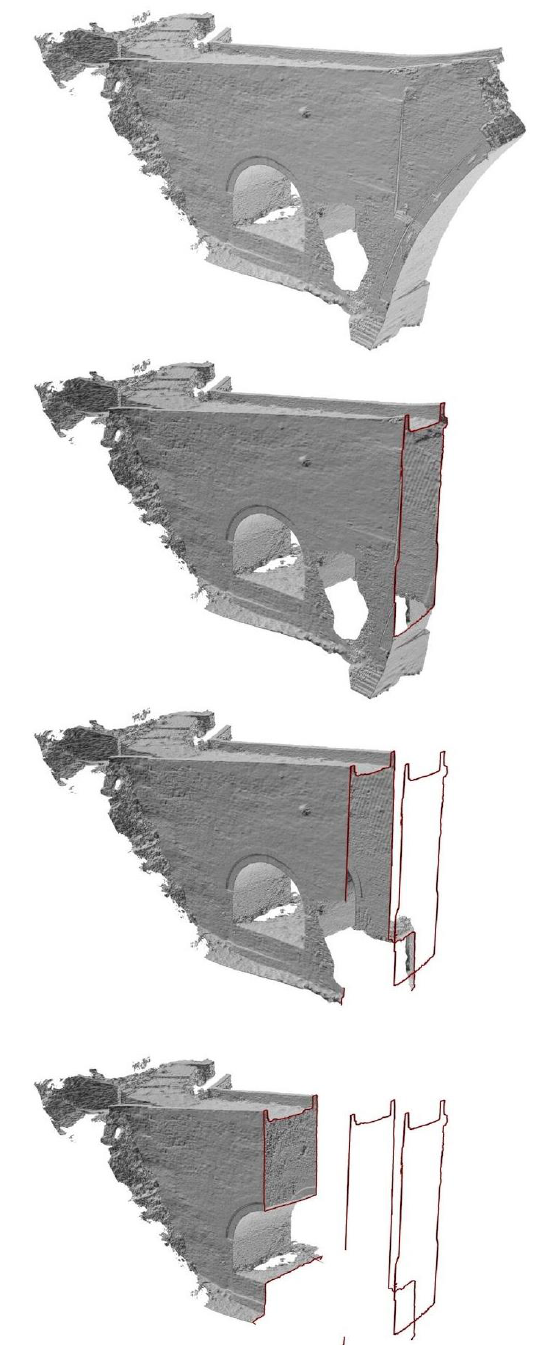
Figure 11. Section creation process directly from the 3D mesh in 3ds Max commercial software.